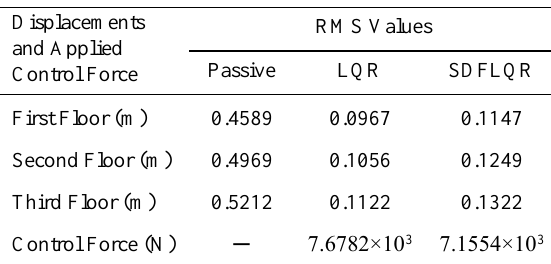
Table 2. Comparison of RMS values of displacement responses of each floor of the offshore steel jacket platform and applied control forces for the both controlled and uncontrolled